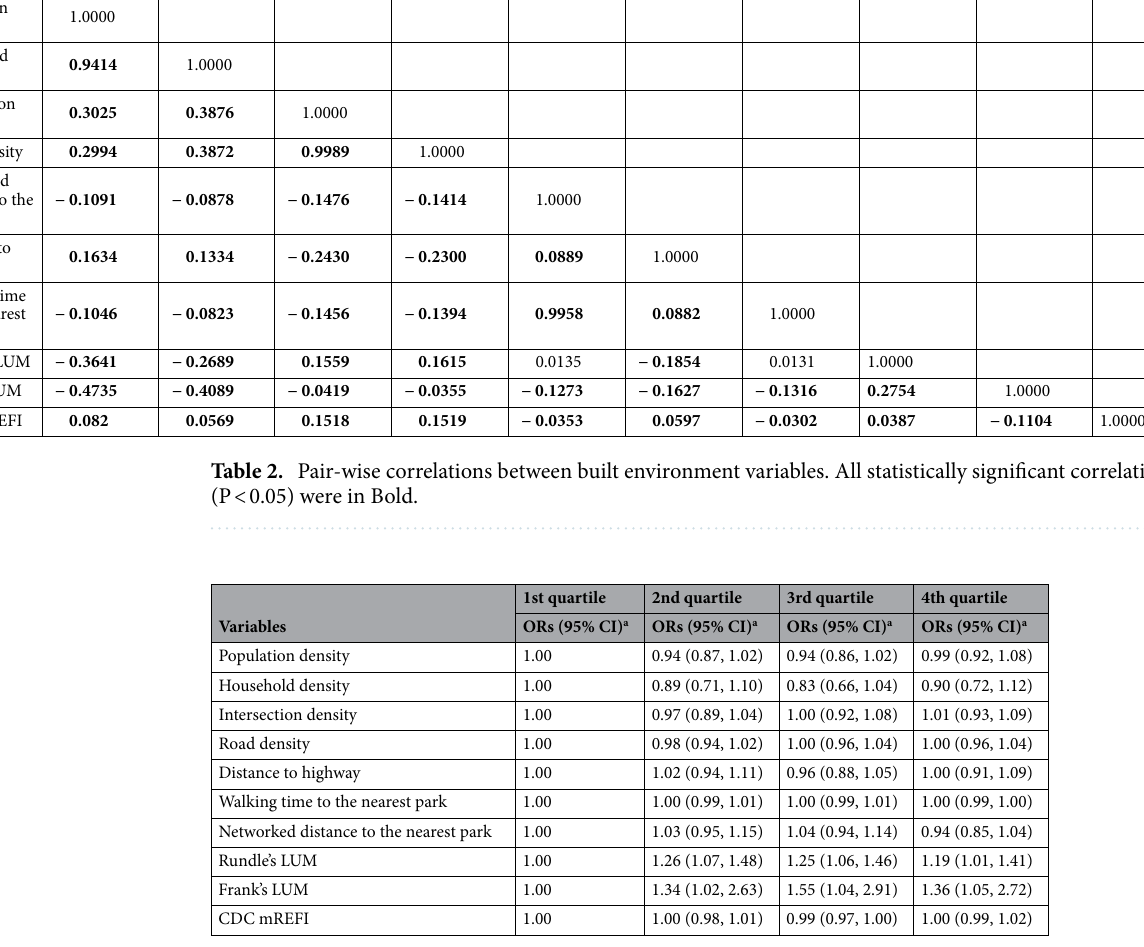
Pairwise correlation analysis was applied to assess the correlation among built environment variables (Table 2). We used Rho (ρ) ≥ 0.5 as the cutoff point to determine whether the correlation was significant. Sig- nificant correlations were observed between population density and household density (ρ = 0.9416), intersec- tion density and road density (ρ = 0.9989), and walking time to the nearest park and networked distance to the nearest park (ρ = 0.9958). To further evaluate the associations between individual built environment variable and telomere length, we used multinominal logistic regression analysis (Table 3). A significant association was observed between Rundle’s LUM and telomere length group. Using 1st quartile telomere length (shortest telomere length) as the reference group increased Rundle’s LUM was associated with increased odds of having high levels of telomere length (2nd quartile: OR 1.26, 95% CI 1.07, 1.48; 3rd quartile: OR 1.25, 95% CI 1.06, 1.46; 4th quartile: OR 1.19, 95% CI 1.01, 1.41, respectively). A similar association was also observed for Frank’s LUM. Increased Frank’s LUM was associated with elevated levels of telomere length (2nd quartile: OR 1.34, 95% CI 1.02, 2.63; 3rd quartile: OR 1.55, 95% CI 1.04, 2.91; 4th quartile: OR 1.36, 95% CI 1.05, 2.72, respectively). The covariates included age, sex, BMI, physical activity, health insurance, born place, acculturation, and census income. No significant association was observed for other built environment variables. Next, we selected seven non-redundant built environment variables and simultaneously included them in the multinominal logistic regression analysis (Table 4). Those variables were population density, intersection density, distance to highway, networked distance to the nearest park, Rundle’s LUM, Frank’s LUM, and CDC mRFEI. The only variable significantly associated with telomere length was still Rundle’s LUM. Increased Rundle’s LUM was associated with increased odds of having high levels of telomere length (2nd quartile: OR 1.27, 95% CI 1.06, 1.52;